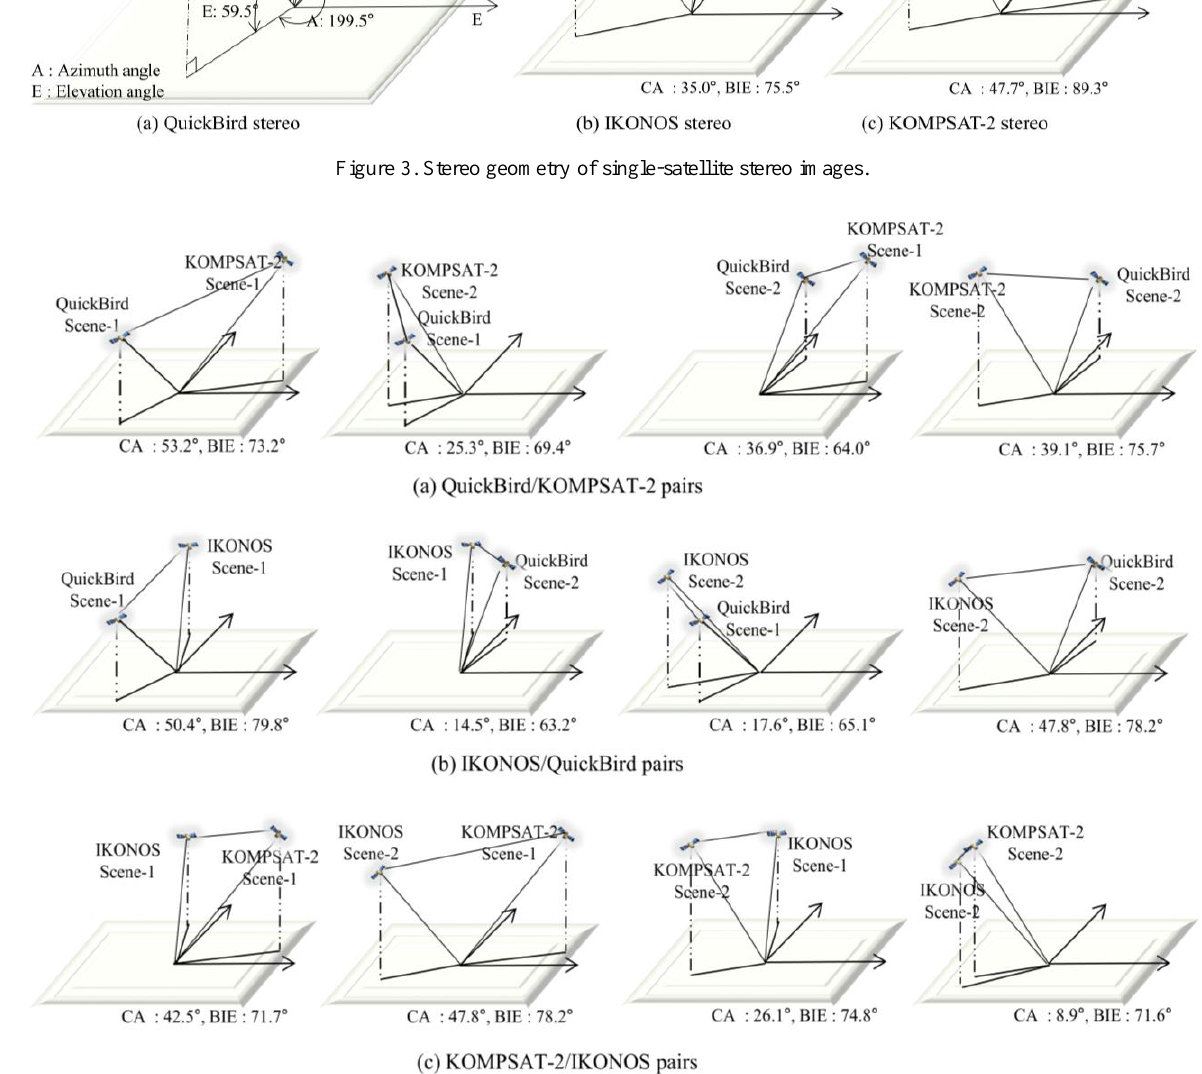
Figure 4. Stereo geometry of dual-satellite stereo